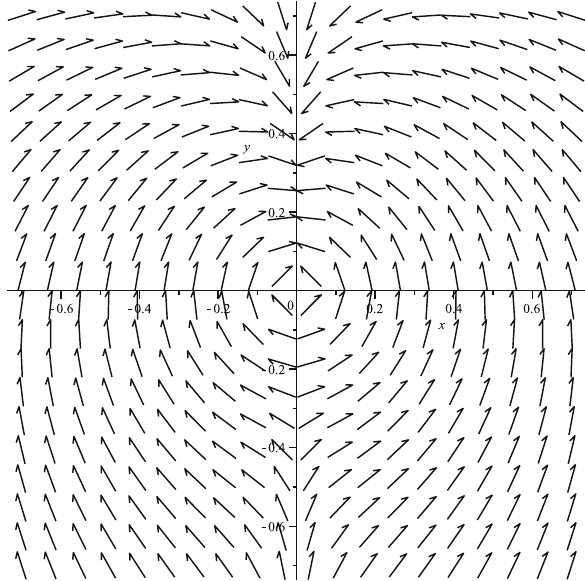
Fig. 5 Plot for the normalized electric field lines given by